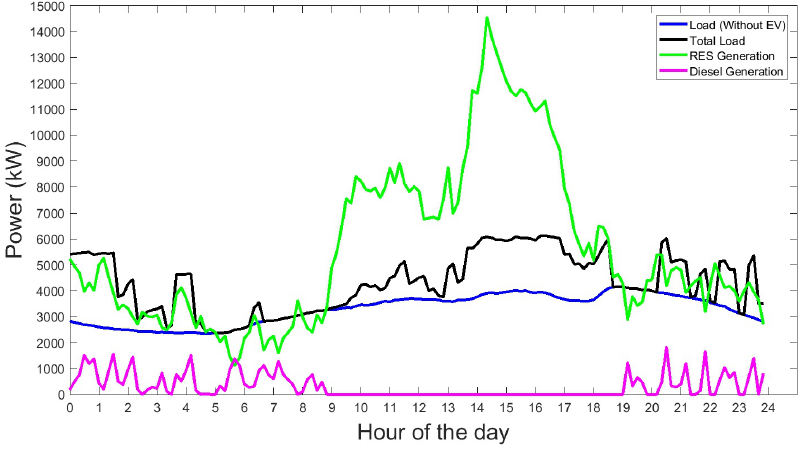
Figure 8. Loads and Generation Profiles for Scenario 9, with smart